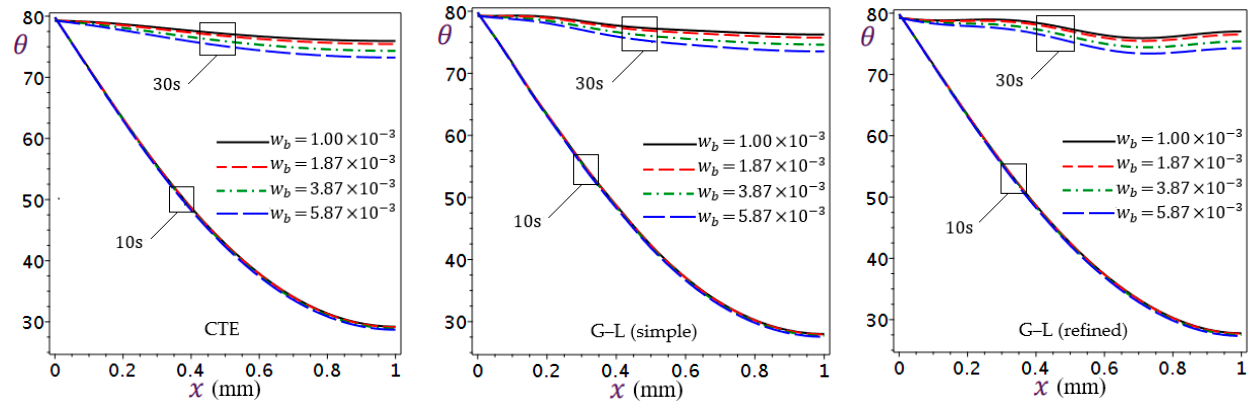
Figure 18. Effect of rate of blood perfusion parameter w b on temperature θ .